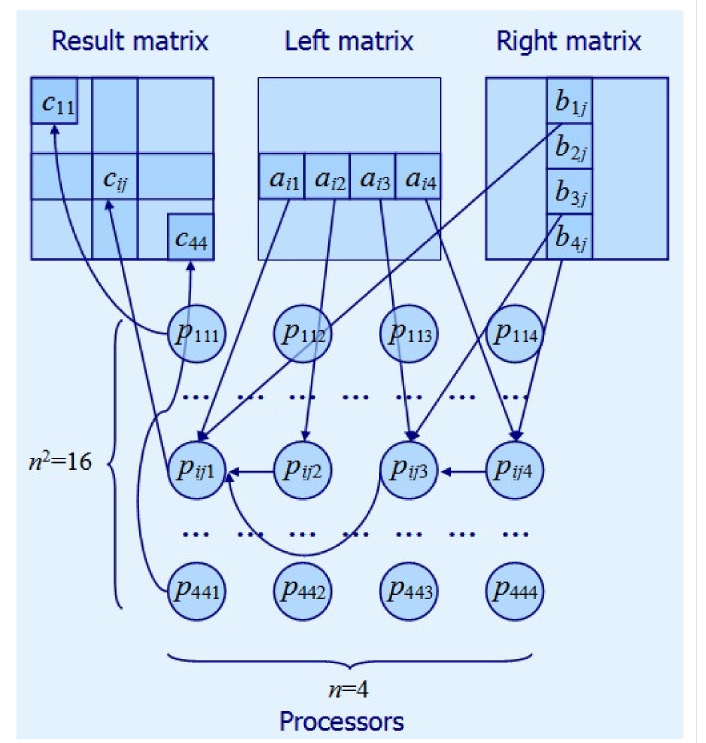
Figure 16. Information graph of the computational process of matrix (4 × 4) multiplication based on 64